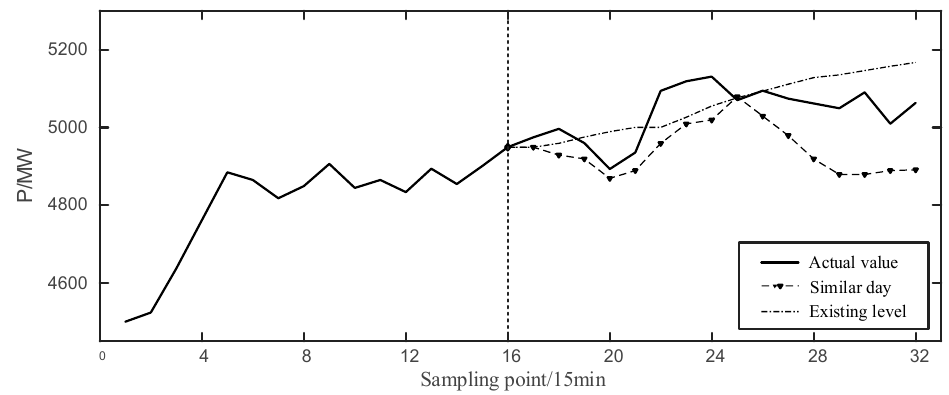
Figure 6. Similar day result at 0:00–4:00 on 6 November 2019.